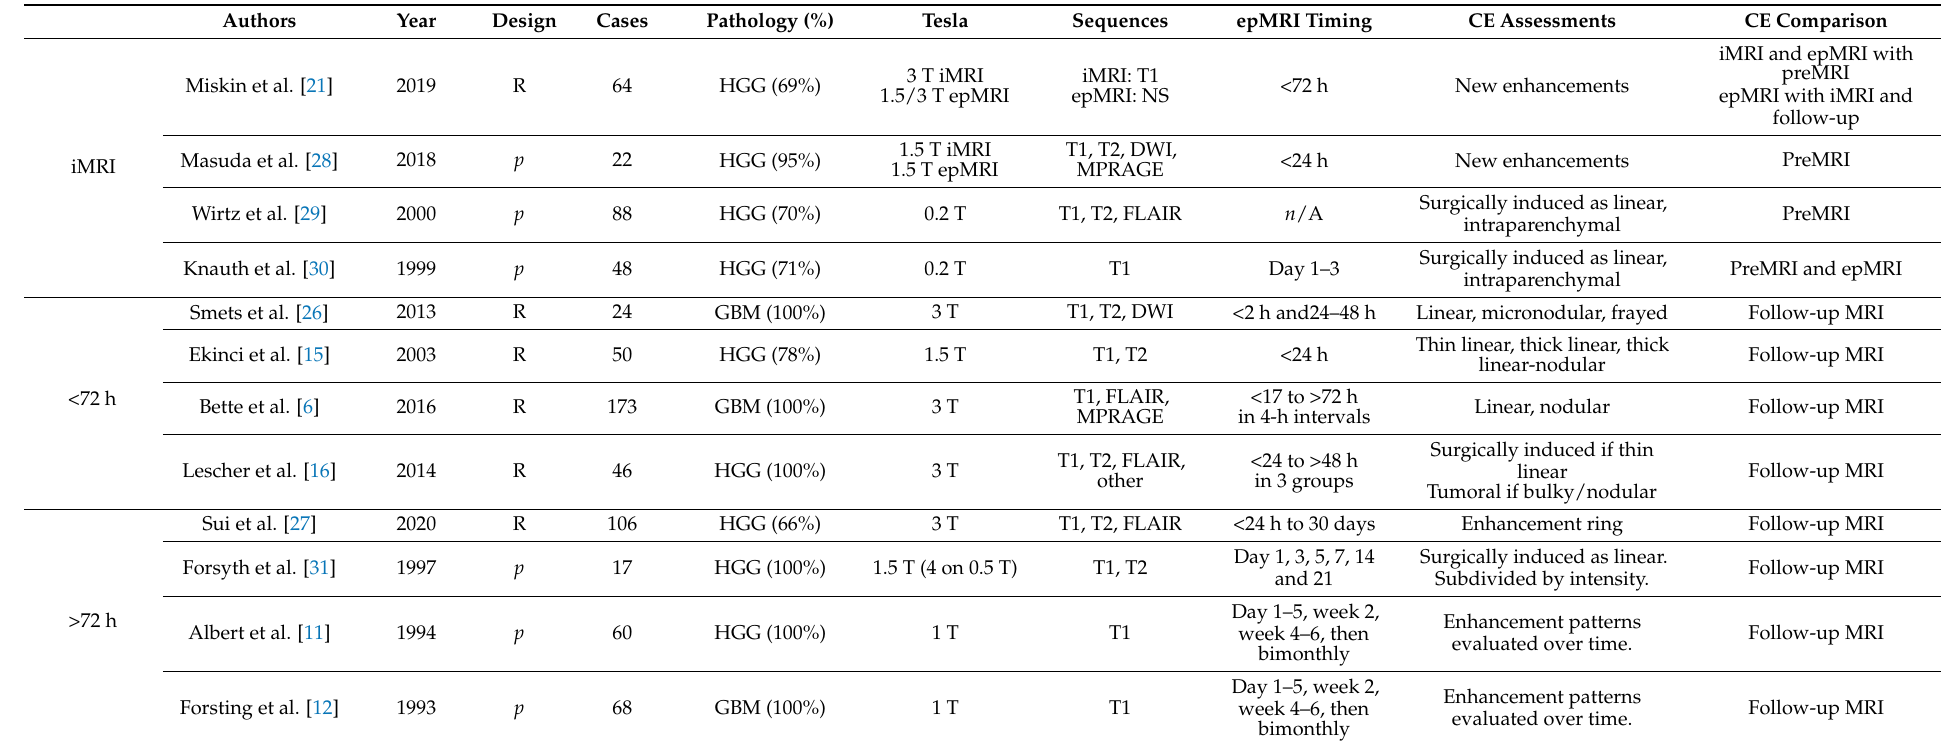
Table 1. Methodology of the included